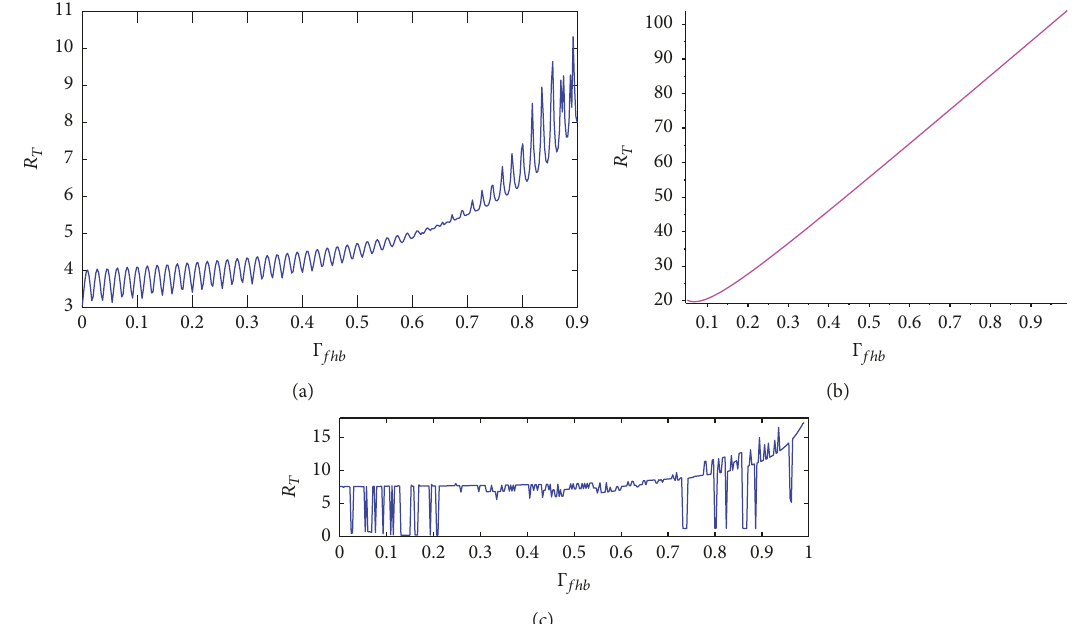
Figure 3: The effect of infection from 𝐼 𝐹 to human beings with bubonic plague on the periodic reproduction number.